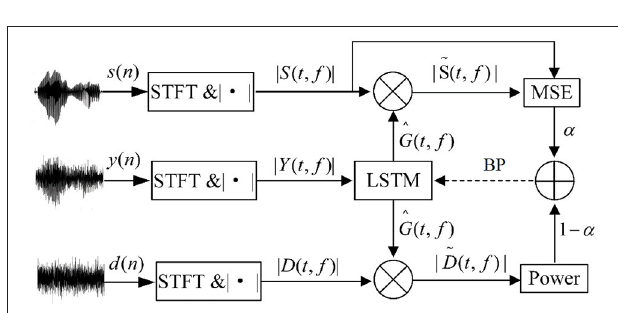
FIGURE 4 | The diagram for the training of the LSTM with weighting